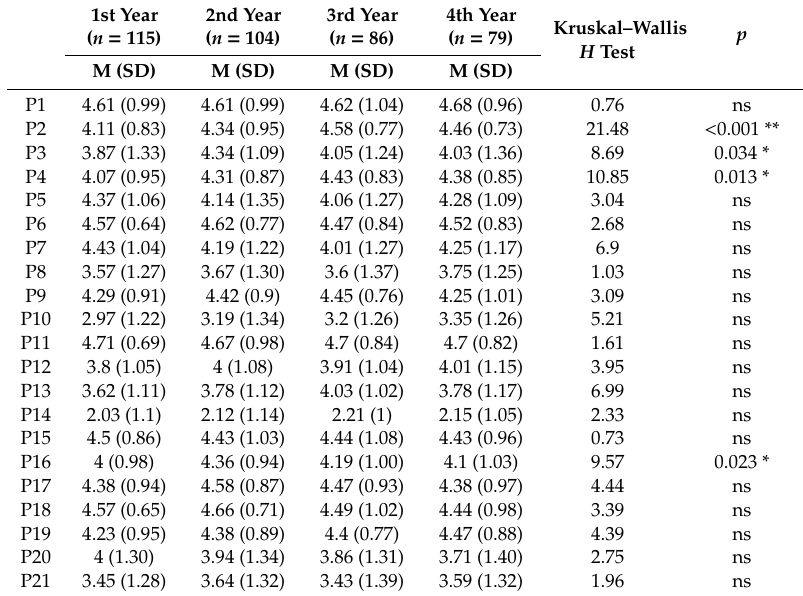
Table 3. Descriptive statistics of the EASE scale items, according to academic year.